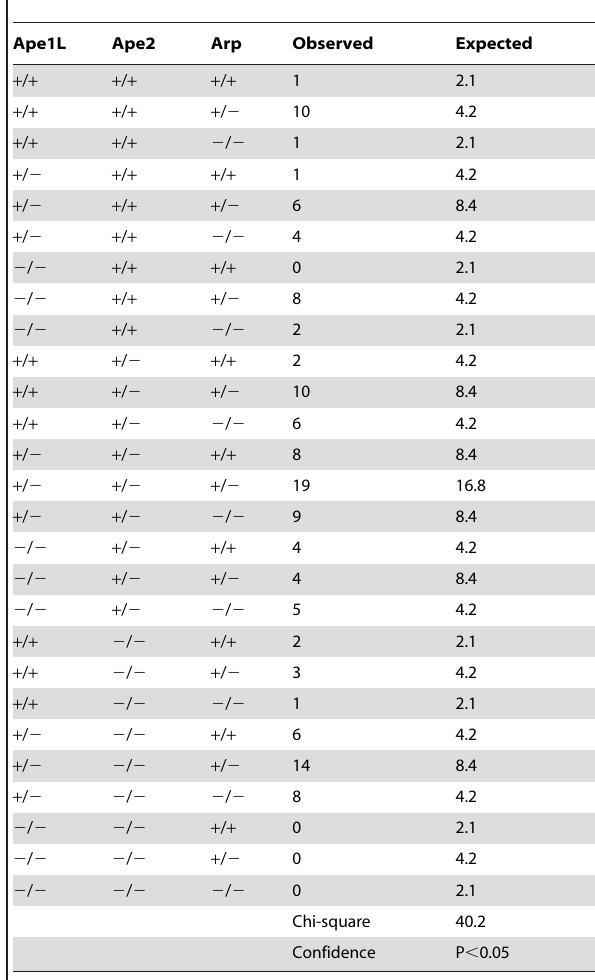
Table 1. Genotypes of progeny from the self-cross of a plant triply heterozygous for ape1L-1 , ape2-1 , and arp-1 and their wild-type alleles.